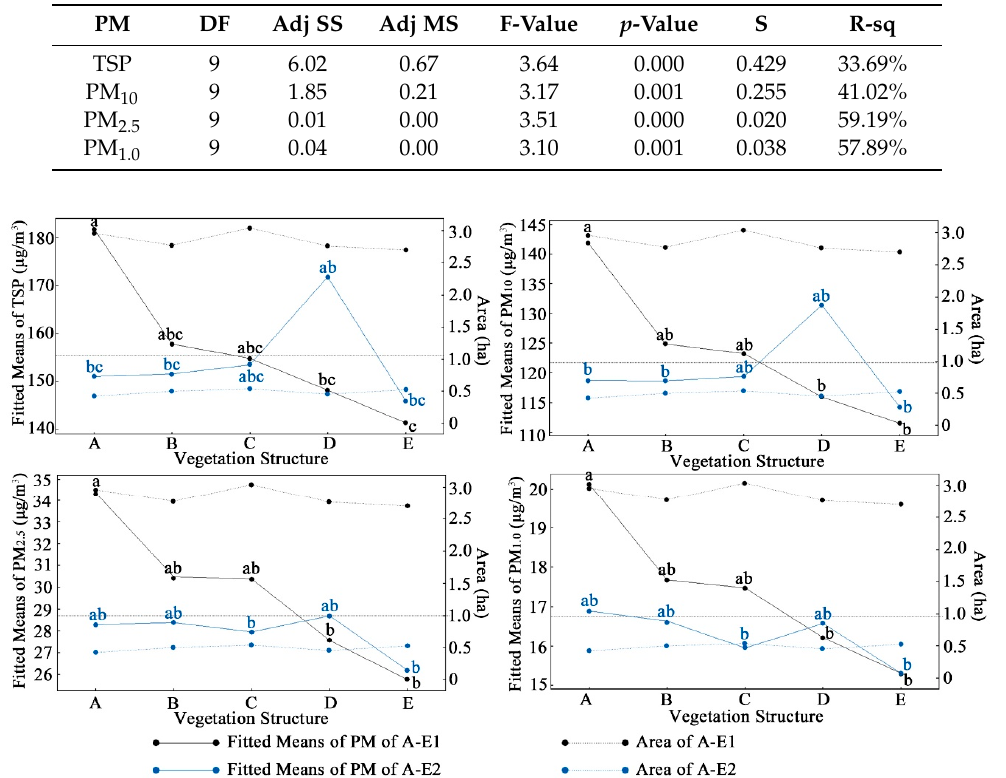
Figure 7. Differences of atmospheric suspended particulate matter concentration under different area gradients. “A” represents open lawn green space, “B” represents semi-open lawn green space, “C” represents semi-closed single-layered broadleaved forest, “D” represents closed single-layered broadleaved forest, “E” represents closed single-layered mixed forest. The lower-case letters in the figure represent the grouping information obtained by multiple comparisons of means using the Tukey method.